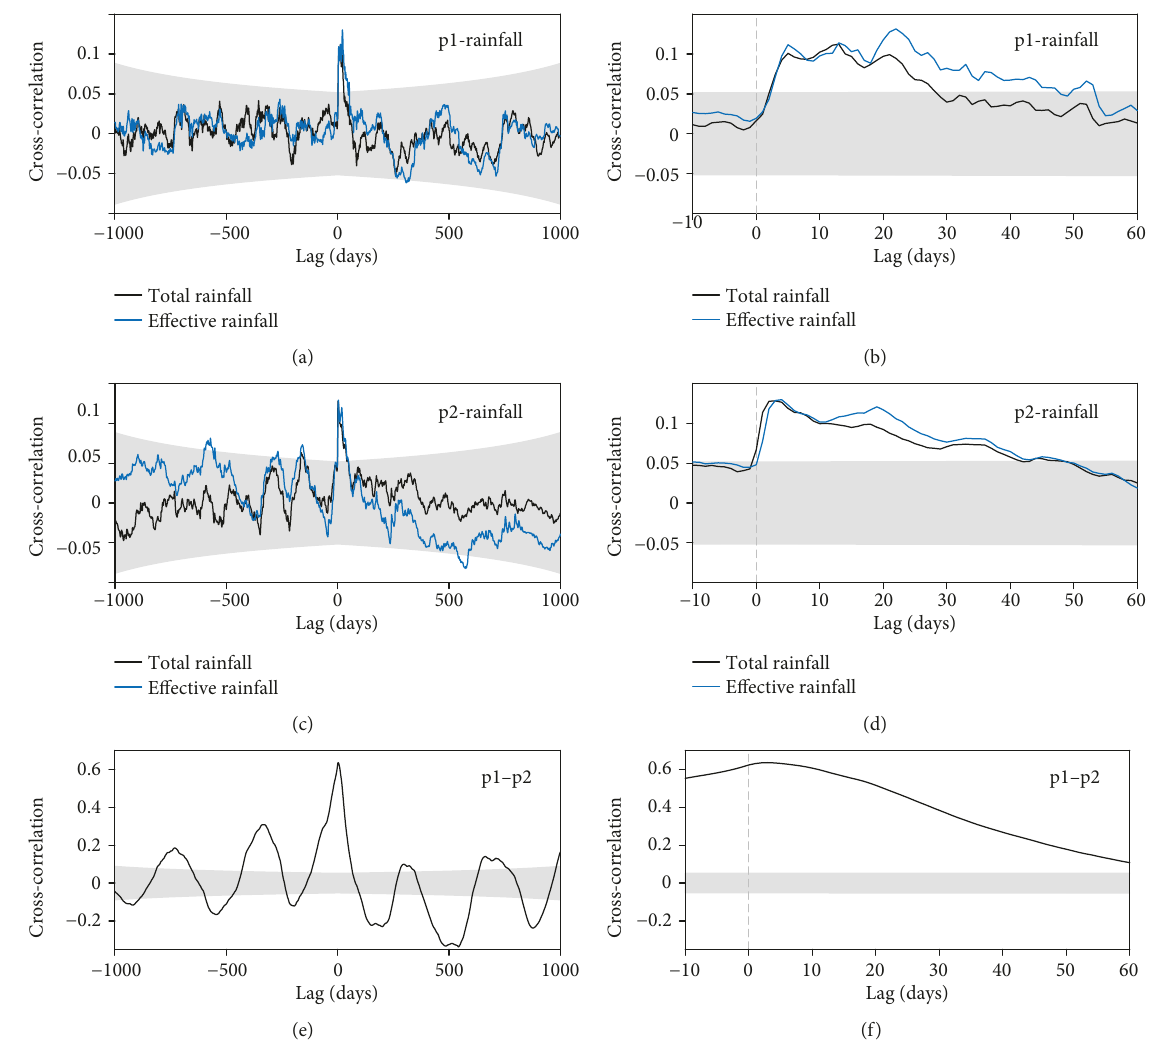
Figure 9: Cross-correlation of water tables and rainfall: (a) phreatic water table in p1, (b) shear surface water table in p2, and (c) water tables in p1 and p2. (d), (e), and (f) Close-ups from (a), (b), and (c),